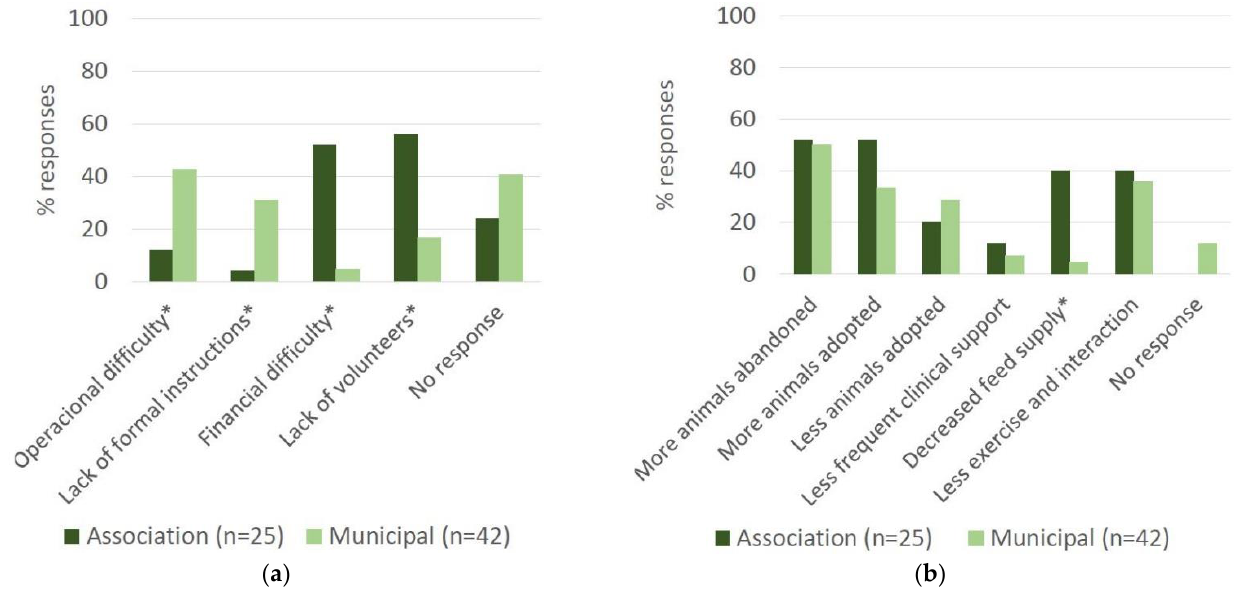
Figure 5. Impact of COVID-19 restrictions on animal shelters: ( a ) impact on routine shelter functioning; ( b ) impact on animal welfare aspects. Data gathered by a questionnaire targeted to Municipal and Non-Municipal shelters (Associations) in March/April 2021. * Indicates statistically significant difference between Municipal shelters and Animal Associations (d.f. 1, p < 0.05).